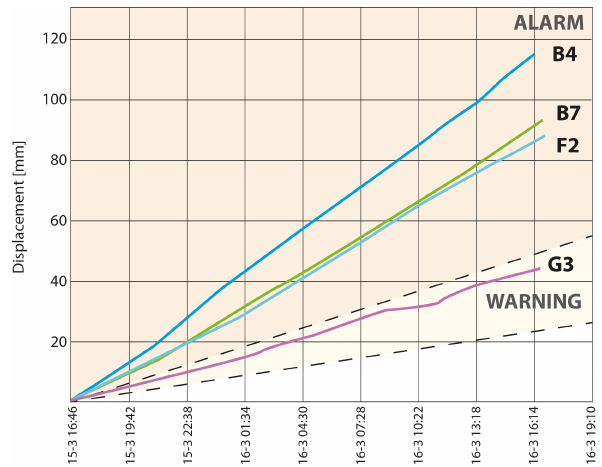
Figure 4. plot of the registered prims’ displacement. The data set is the same in Fig. 3 but this representation is dedicated to ROLE-2. On the website, several plots related to different periods are pub- lished and updated in near-real time by